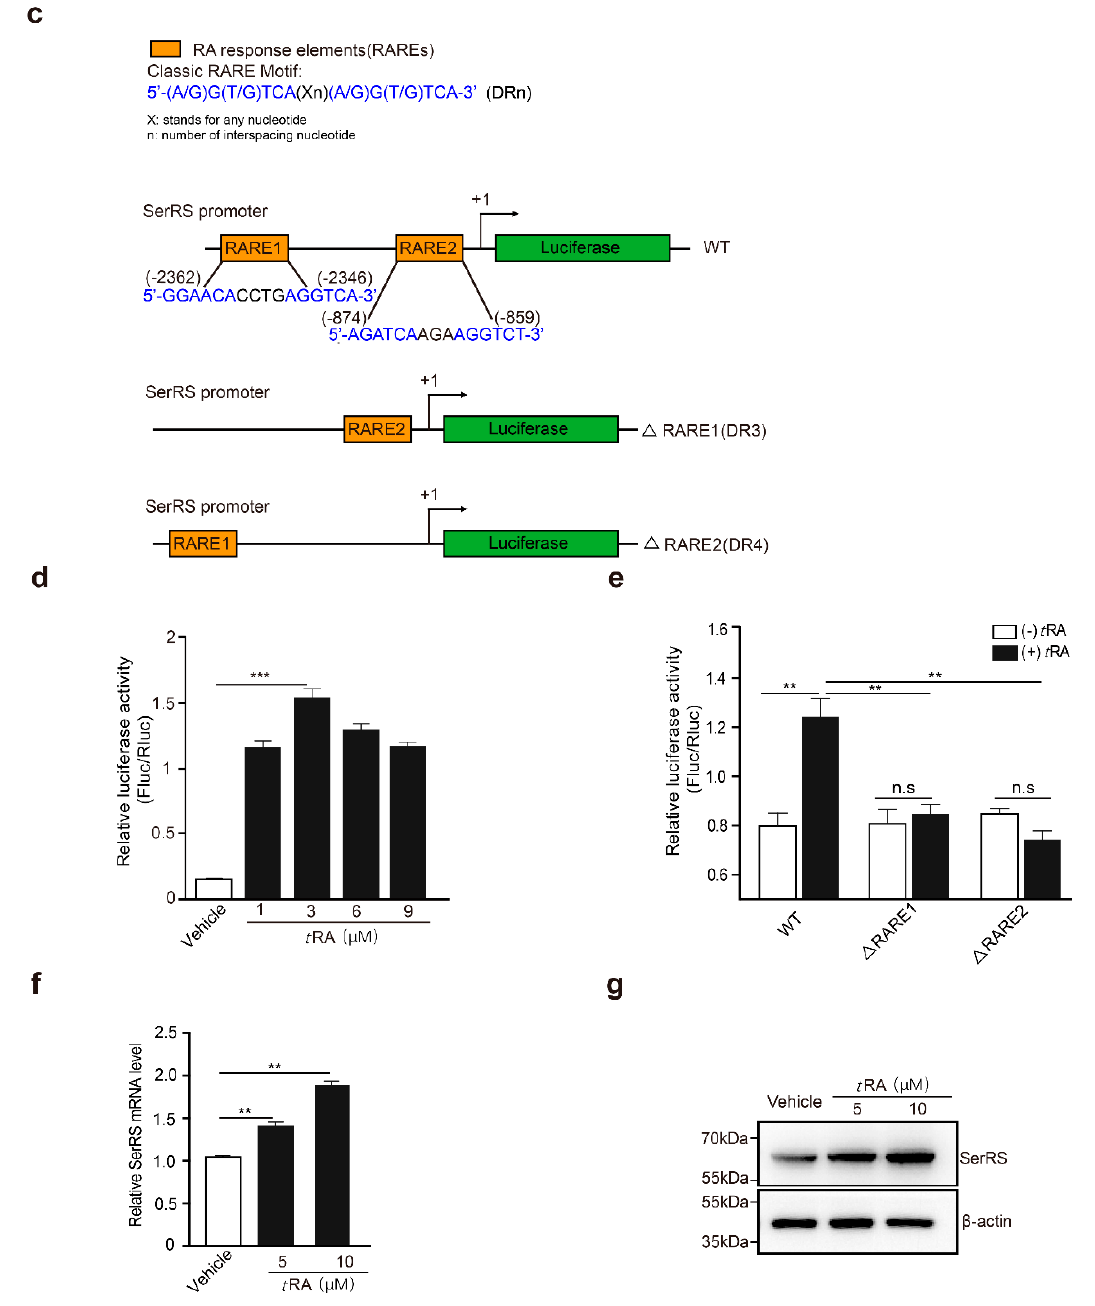
Figure 2. All-trans retinoic acid ( t RA) enhanced the transcription of SerRS to suppress VEGFA expression in HaCaT cells. HaCaT cells were pretreated with vehicle (DMSO) or t RA 24 hours before UV radiation. ( a ) mRNA levels of VEGFA in HaCaT cells were detected by RT-PCR. ( b ) VEGFA secretion was determined via ELISA. ( c ) Details of constructed plasmids, all with luciferase reporter, but discriminatively with intact SerRS promoter or the deleted binding sites of RARE1 or RARE2. ( d ) Relative SerRS activity was analyzed via luciferase assay in HaCaT-SerRS WT cells. ( e ) Relative SerRS activity was analyzed via luciferase assay in HaCaT-SerRS WT , HaCaT-SerRS Δ RARE1 , and HaCaT-SerRS Δ RARE2 cells. ( f ) Transcriptional levels of SerRS were analyzed with RT-PCR. ( g ) Western blot analysis of SerRS expression; β -actin serves as a loading control. All values above are shown as means ± SEM ( n = 3, ** p < 0.01, *** p < 0.001).